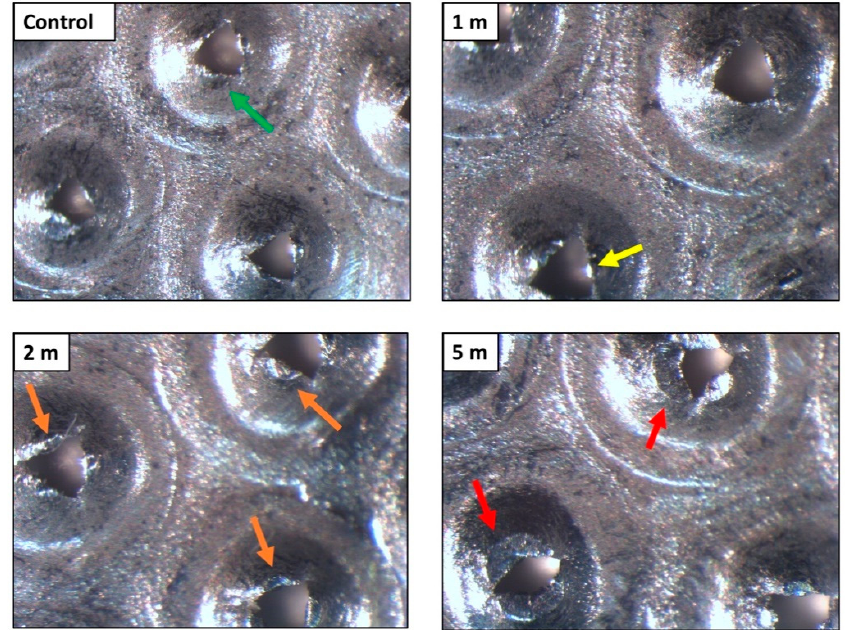
Figure 6. Reflected light microscopy of the Rigeneracons ® internal metallic grid when unused (control), after 1 min, 2 min and after 5 min of processing. The control grid showed no damage of the cutting edges of the hexagonal pores (green arrow). The tips of the cutting surfaces appeared to increase in damage proportional to processing time. The damage ranged from mild wear (yellow arrow), medium wear (orange arrows), up to a complete loss of the cutting edges of the hexagonal pores (red arrows).